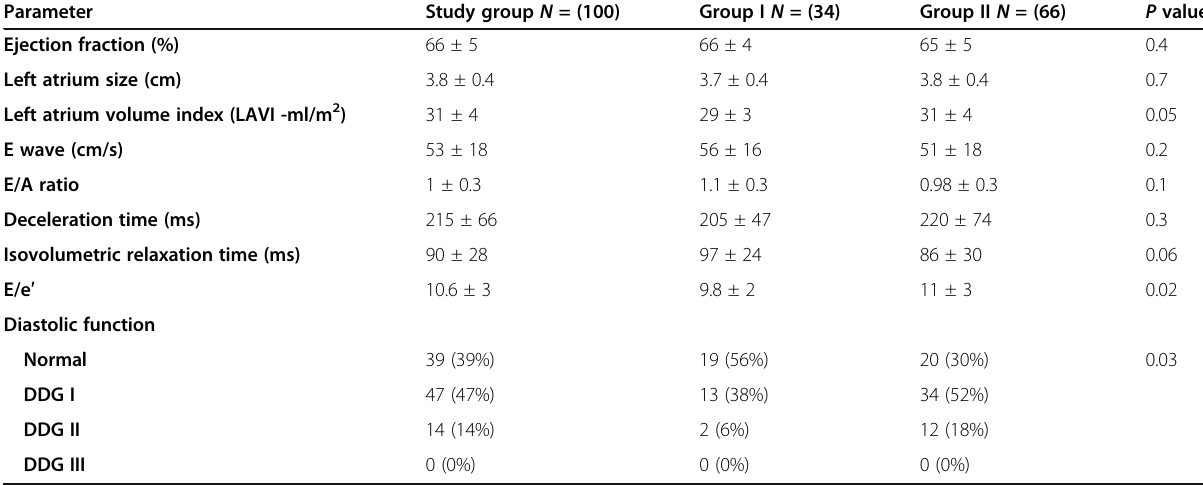
Table 2 Comparison between echocardiographic findings (systolic and diastolic functions) of the study group classified according to glycated